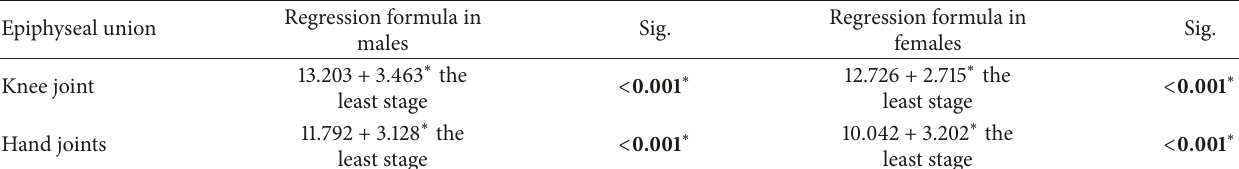
Table 4: Regression formulae for male and female groups in knee and hand joints.